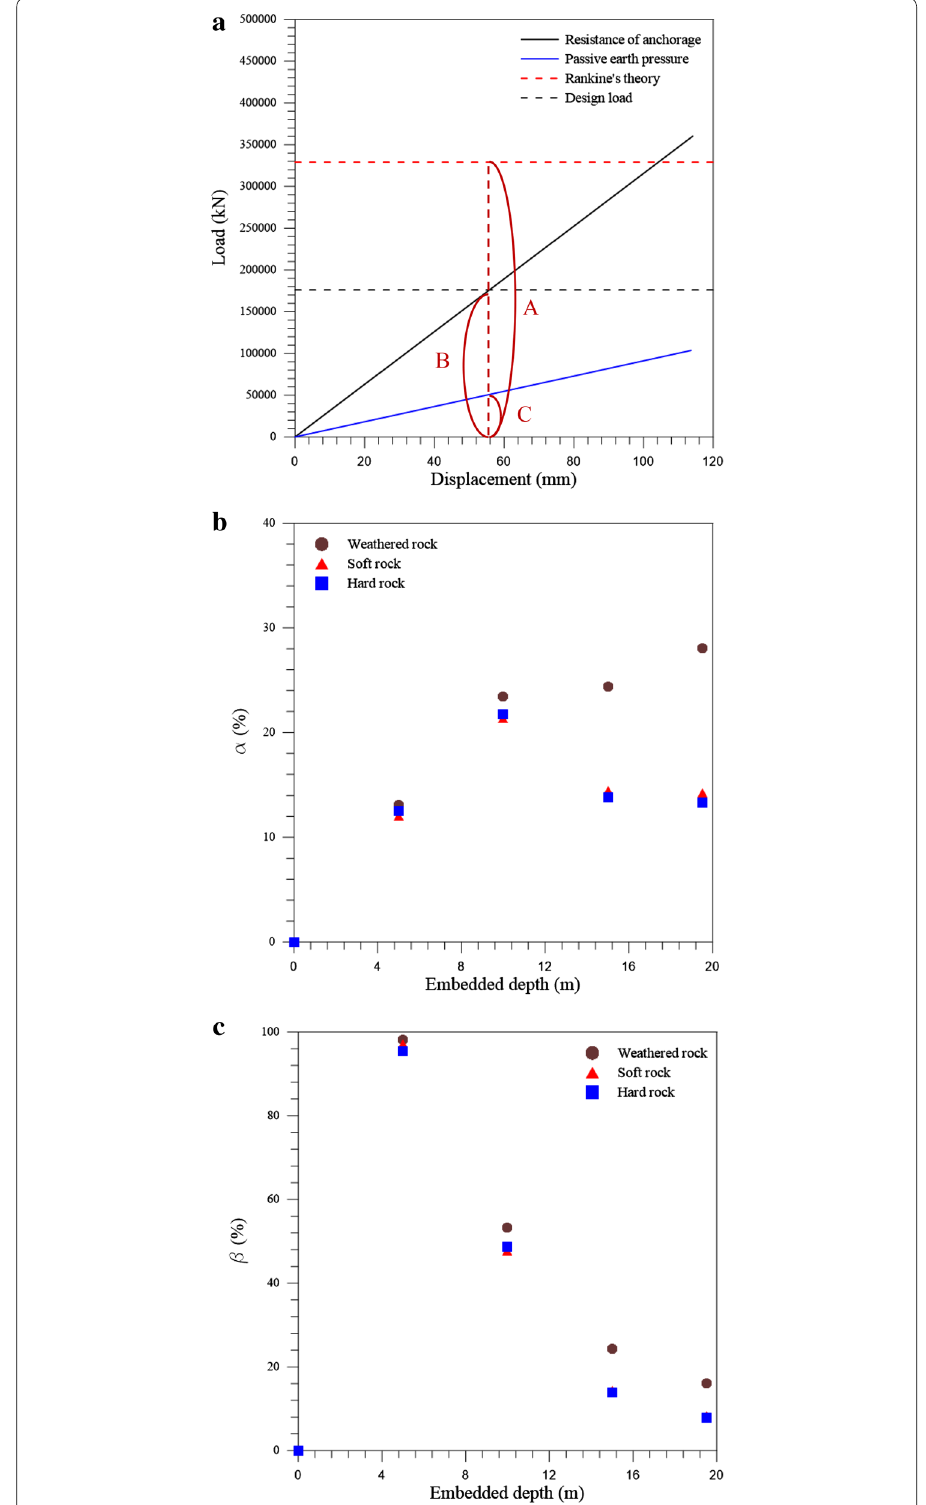
Fig. 4 Evaluation of the passive resistance in front of the anchorage: a definition of α and β; b α (%) value according to the embedded depth; and c β (%) value according to the embedded